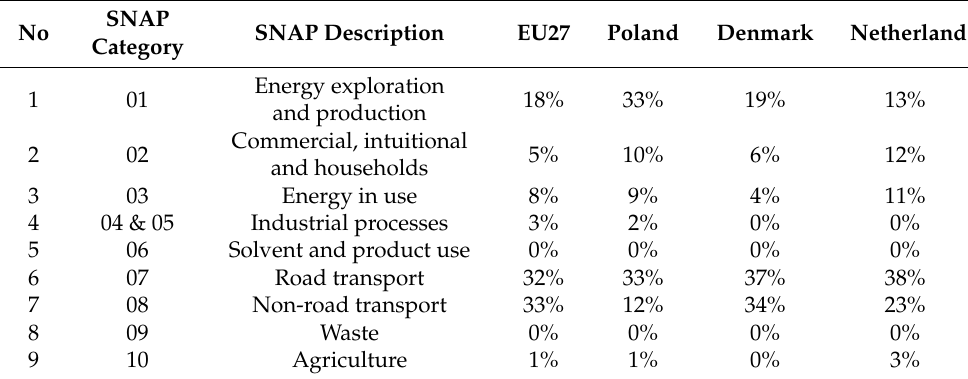
Table 1. Contribution of NOx emissions by individual SNAP category (Selected Nomenclature for sources of Air Pollution).